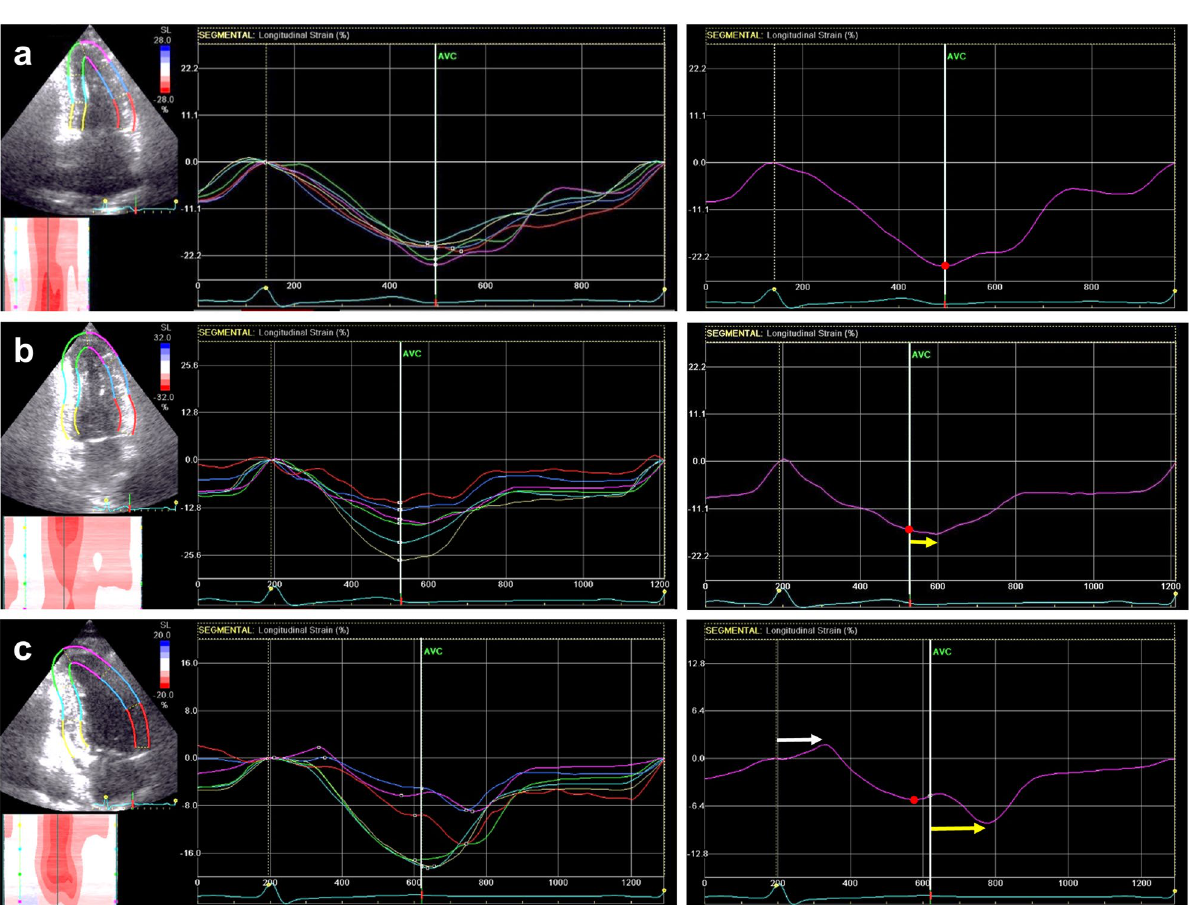
Figure 1. Representative strain–time curves in six segments (left) and the apical anterior segment (right) of the apical 2-chamber view. ( a ) An 83-year-old female with 29% diameter stenosis of the left anterior descending artery (LAD) derived from quantitative coronary angiography. ( b ) A 67-year-old male with 58% LAD stenosis. ( c ) A 56-year-old male with 88% LAD stenosis. The absolute value of the peak systolic strain (red circle) decreased, and early systolic lengthening (ESL) and postsystolic shortening (PSS) became larger with the severity of LAD stenosis, resulting in prolonged T ESL (white arrow) and T PSS (yellow